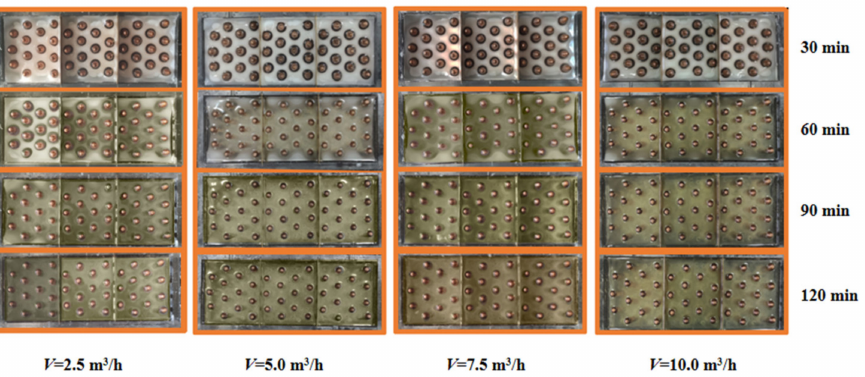
Figure 10. Melting of paraffin on the upper surface of phase change heat storage for CASE4 at different V .